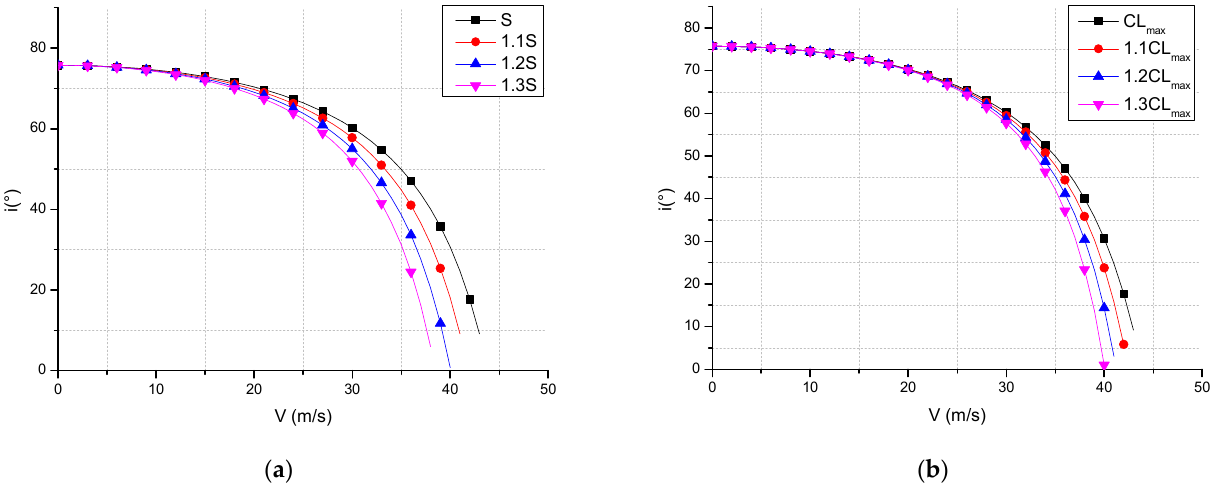
Figure 13. The influence of aerodynamic parameters on the flight corridor. ( a ) Influence curve of wing area; ( b ) influence curve of maximum lift coefficient.